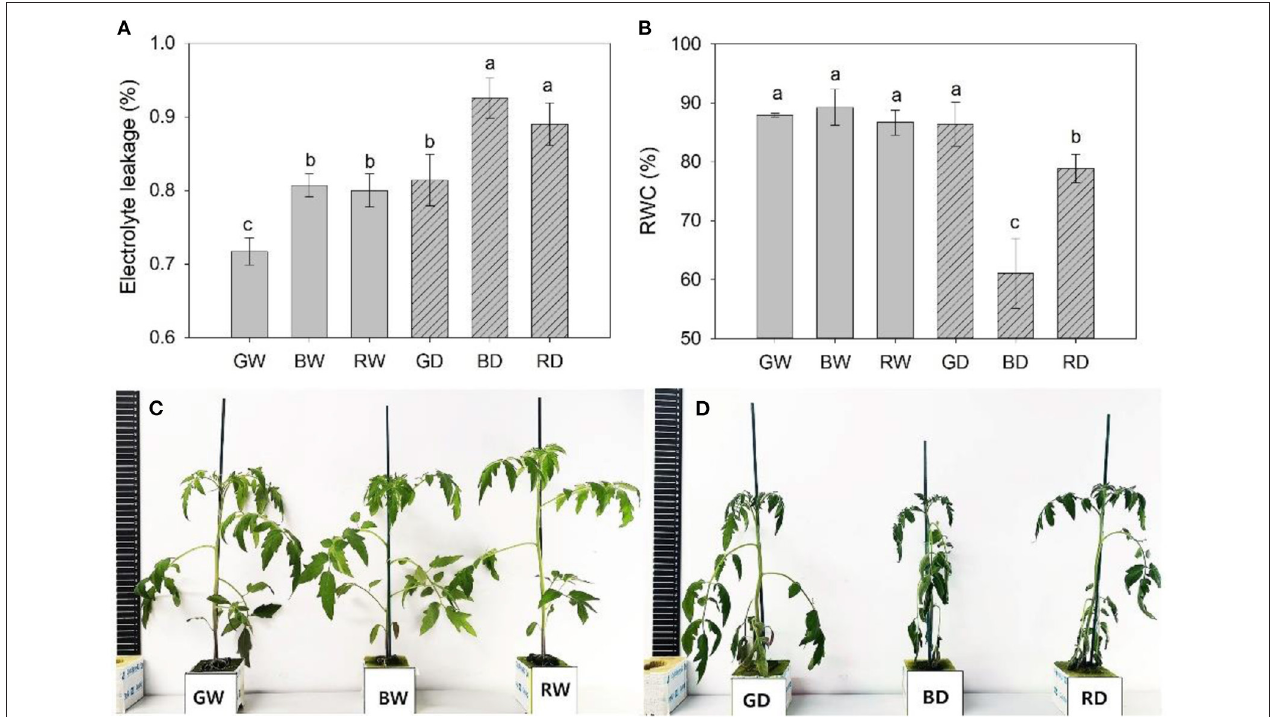
FIGURE 3 | The electrolyte leakage (A) , relative water content [RWC, (B) ], and phenotype (C,D) of plants were treated with different water and light spectral condition for 9 days. RW, BW, and GW: well-water combined with red, blue, and green LED light, respectively; RD, BD, and GD: drought stress combined with red, blue, and green LED light, respectively. The PPFD for all the treatments was 200 µ mol m − 2 s − 1